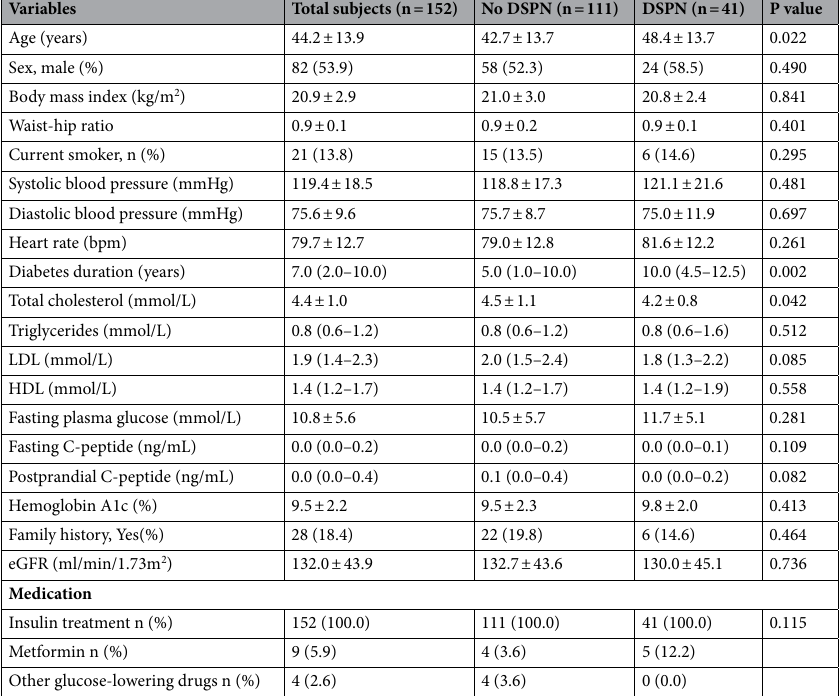
Table 1. Baseline characteristics of enrolled subjects with type 1 diabetes. HDL, high-density lipoprotein; LDL, low-density lipoprotein; eGFR, estimated glomerular filtration.